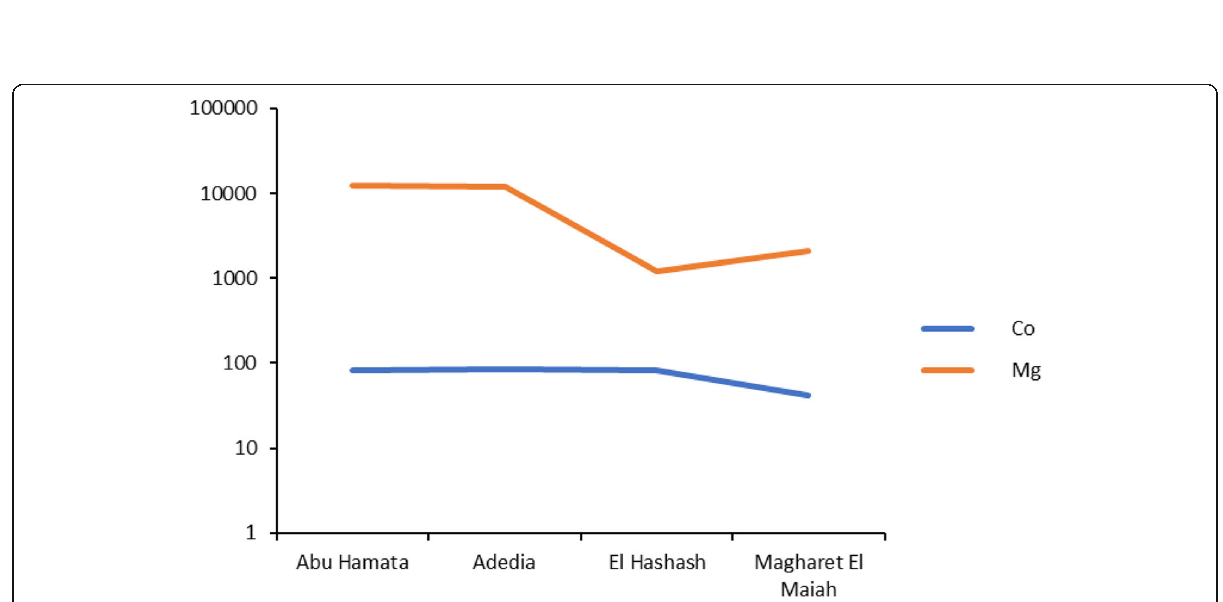
Fig. 11 Correlation between cobalt and magnesium in the studied Paleozoic